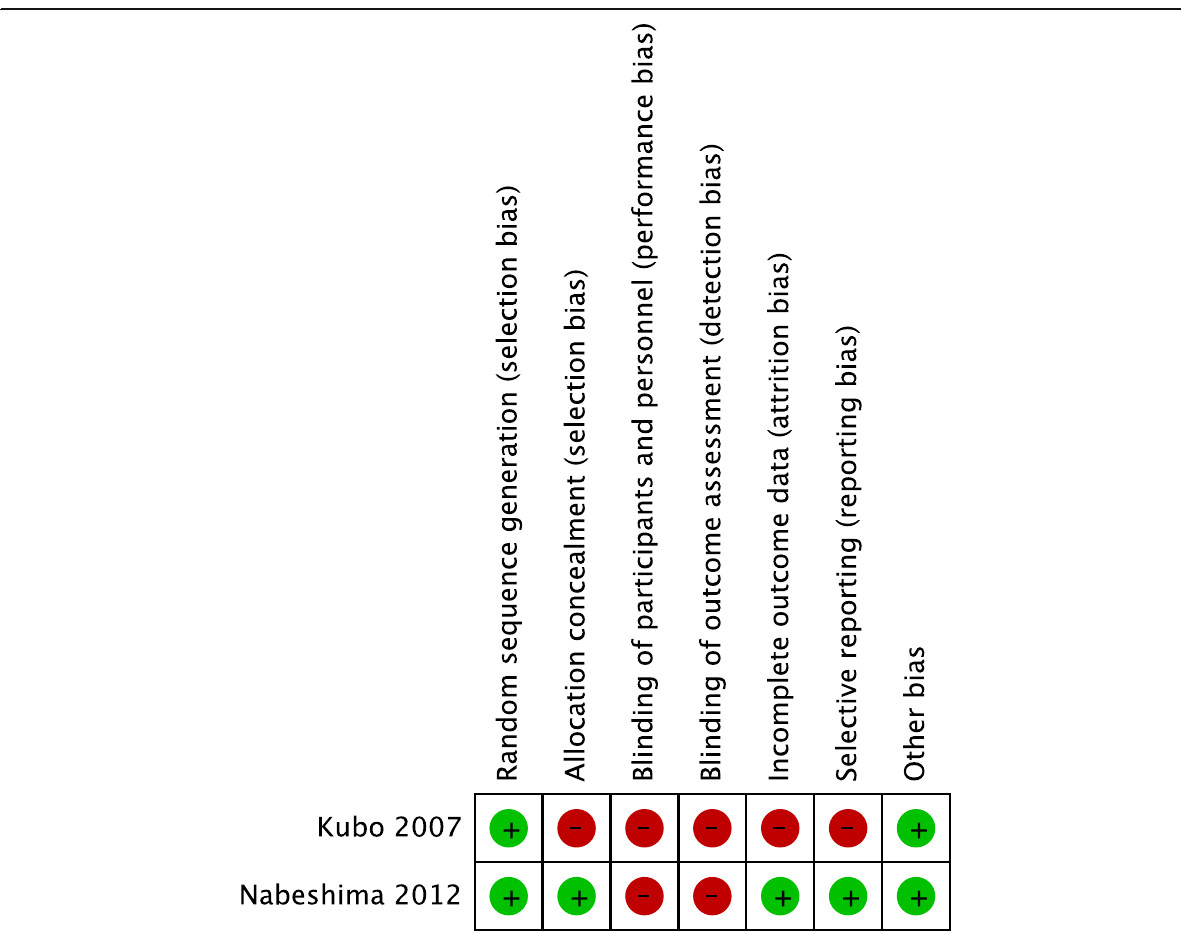
Incomplete Measurement Selective outcome data of outcomes reporting